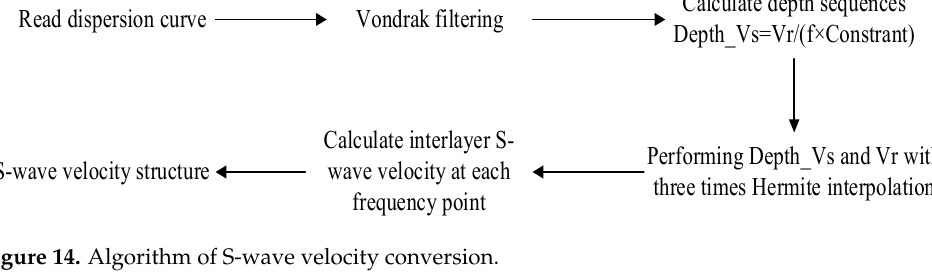
Figure 15. S-wave velocity structure of hierarchical frequency fusion and superimposed averaging. According to the criteria for classifying soil types in the Code for Seismic Design of Buildings and the wave velocity test data from the geotechnical investigation boreholes close to the site to be tested in the Siming District, the stratigraphic structure of two meth- ods at the test site was categorized. The stratigraphic delineation results of the two meth- ods is shown in Table 2.